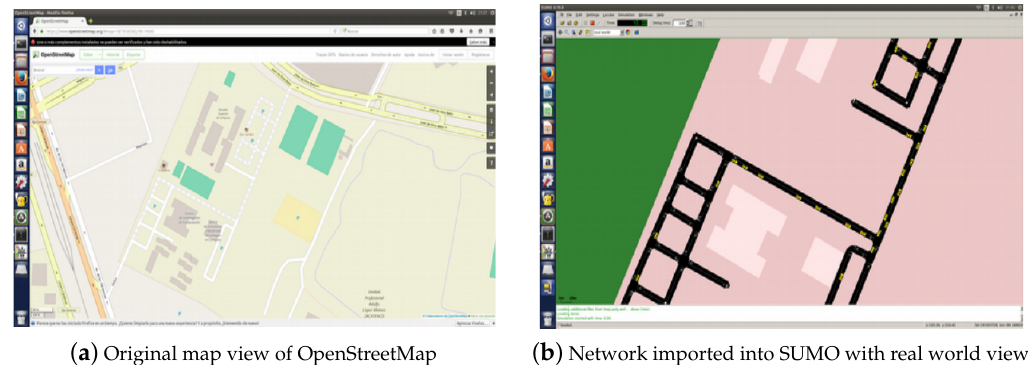
Figure 1. Example of converting a map in